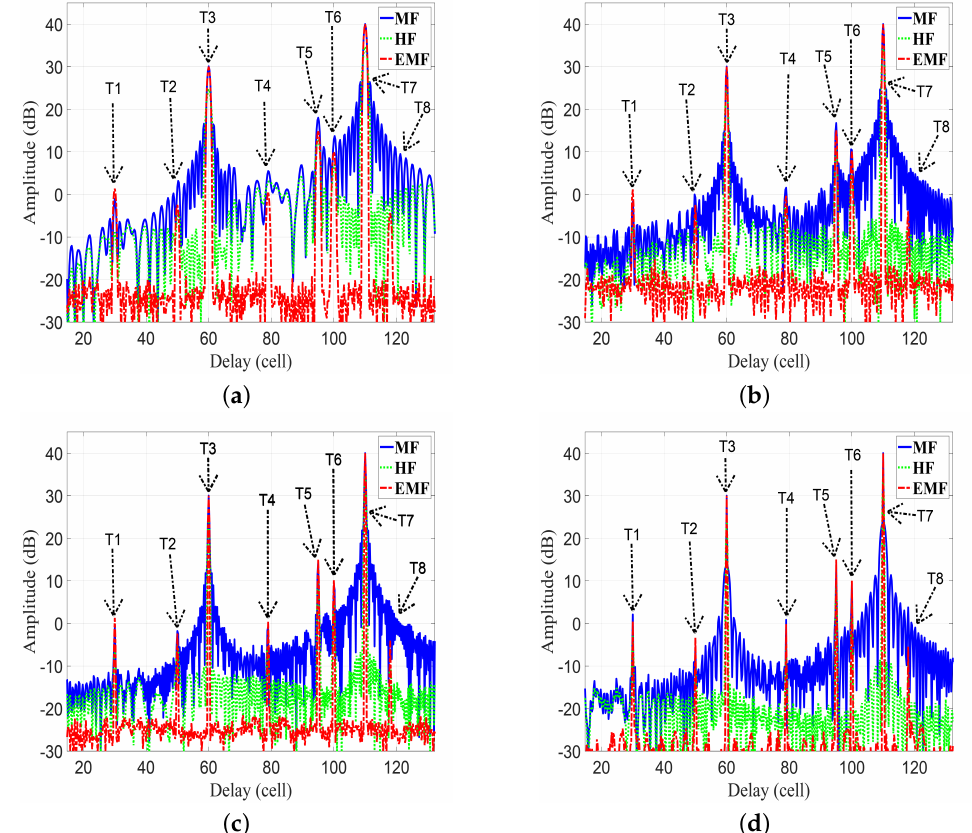
Figure 17. The amplitude responses of the MF, HF, and proposed EMF for different values of LFM waveform parameters: ( a ) case 1, ( b ) case 2, ( c ) case 3, ( d ) case